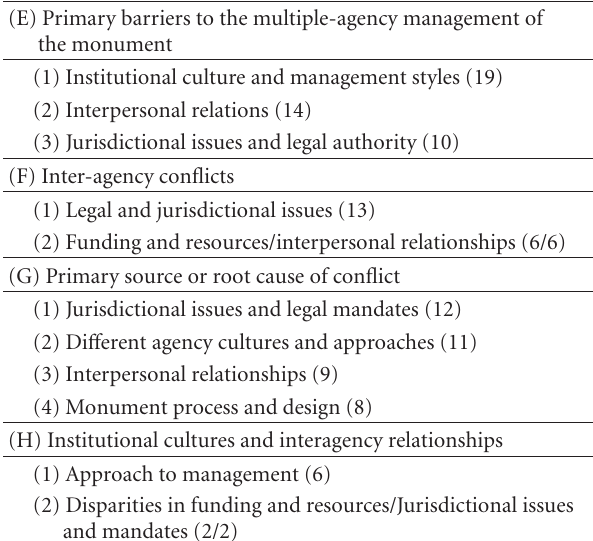
Table 4: Barriers to multiple-agency management: interviewee responses by conceptual category (e)–(h). Numbers in parentheses indicate number of responses from a total pool of 23 respondents.